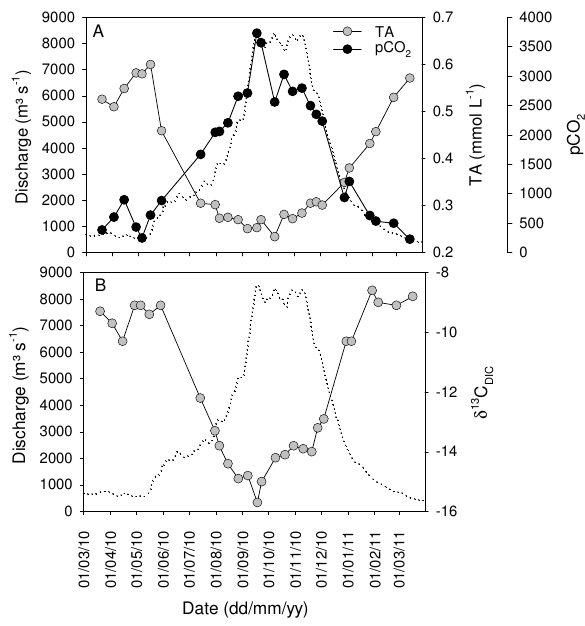
Fig. 7. Seasonal variations of daily discharge (dotted lines) and (A) total alkalinity (grey symbols) and p CO 2 (black symbols), and (B) δ 13 C signatures of dissolved inorganic carbon, in the Oubangui River at Bangui between March 2010 and March 2011.